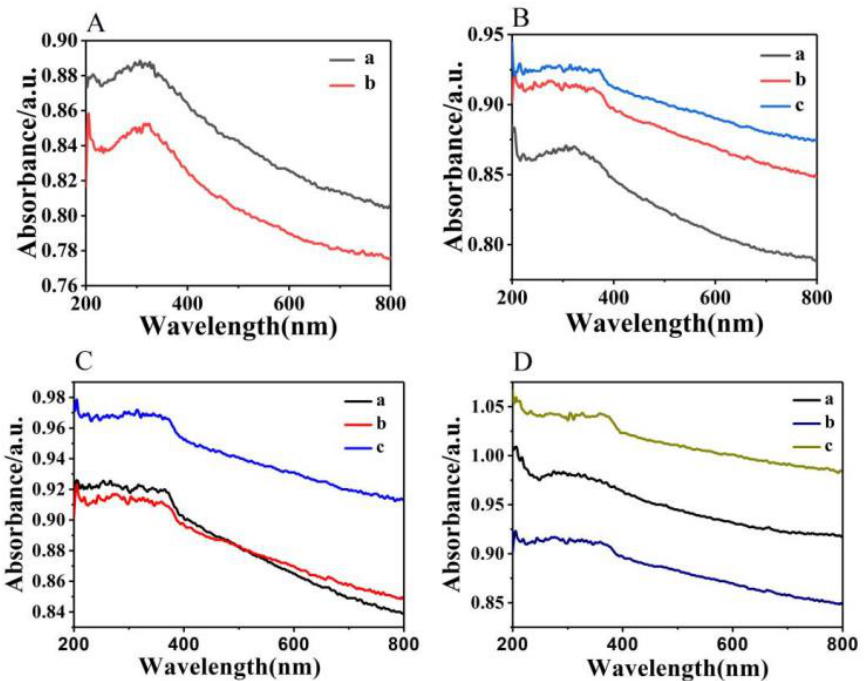
Figure 6. ( A ) (a): Ultraviolet-to-visible (UV–VIS) absorption foamed nickel in growing seed layers, and (b): UV–VIS absorption of foamed nickel. ( B ) UV–VIS absorption of ZnO grown at different solution concentrations: (a) 20 mmol/L, (b) 40 mmol/L, and (c) 60 mmol/L. ( C ) UV–VIS absorption of ZnO grown at different reaction times: (a) 2 h, (b) 4 h, and (c) 6 h. ( D ) UV–VUS absorption of ZnO grown at different reaction temperatures: (a) 75 °C, (b) 95 °C, and (c) 115 °C.